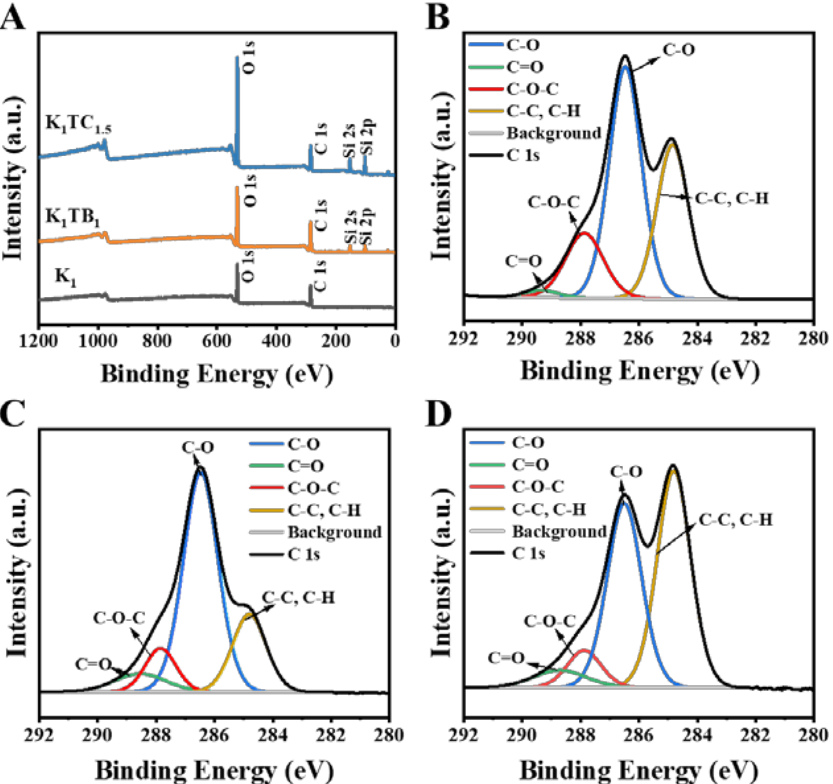
Figure 3. XPS spectra of K 1 , K 1 TB 1 , and K1TC 1.5 aerogels ( A ) and XPS spectra in the C 1s region for K 1 aerogels ( B ), K 1 TB 1 aerogels ( C ), and K 1 TC 1.5 aerogels ( D ).